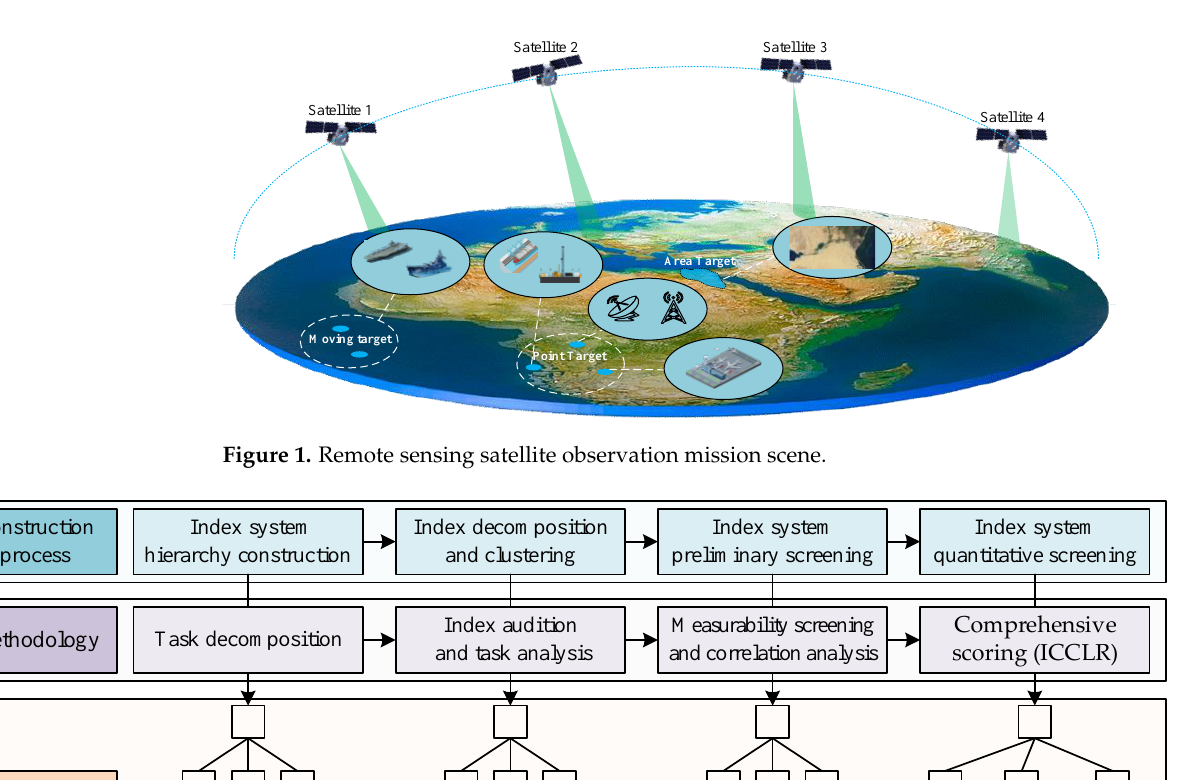
Figure 1. Remote sensing satellite observation mission scene.